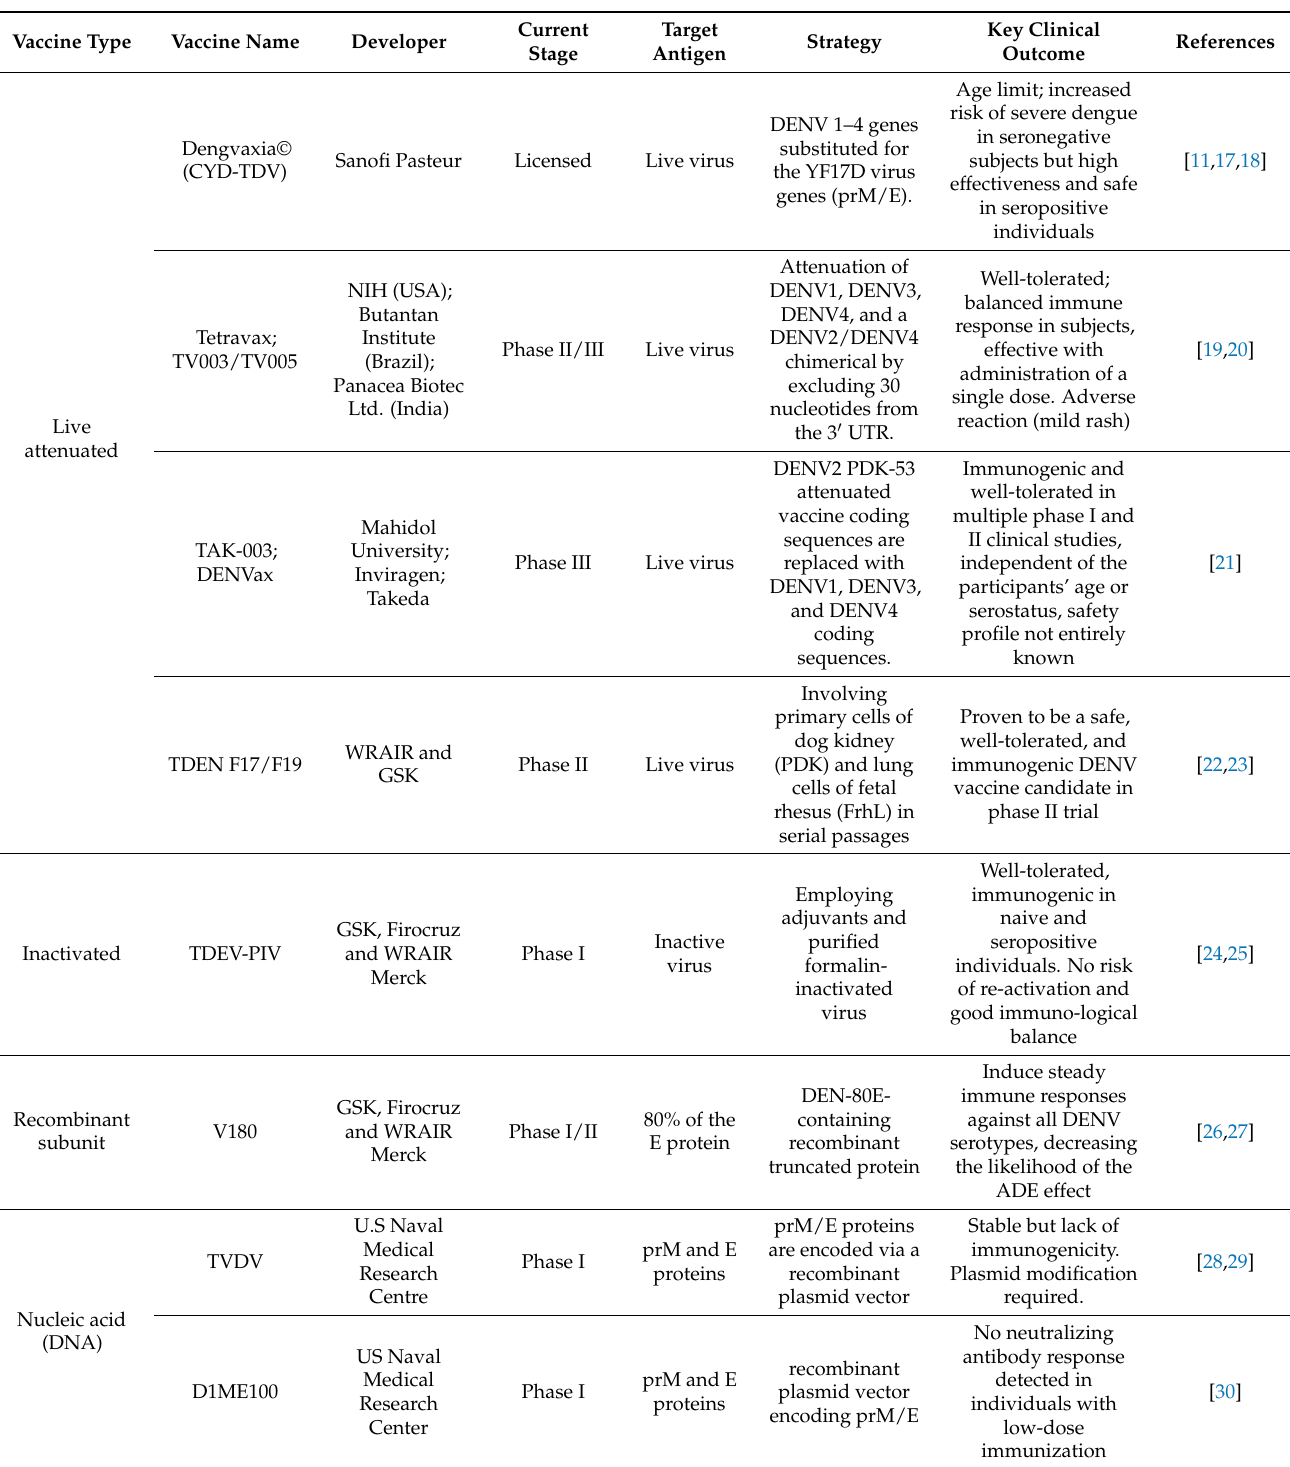
Table 1. DENV vaccines currently under